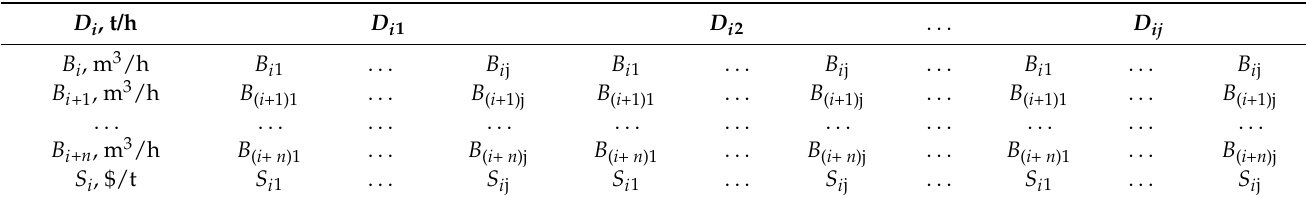
Table 2. General View of the Boiler Unit Feasibility